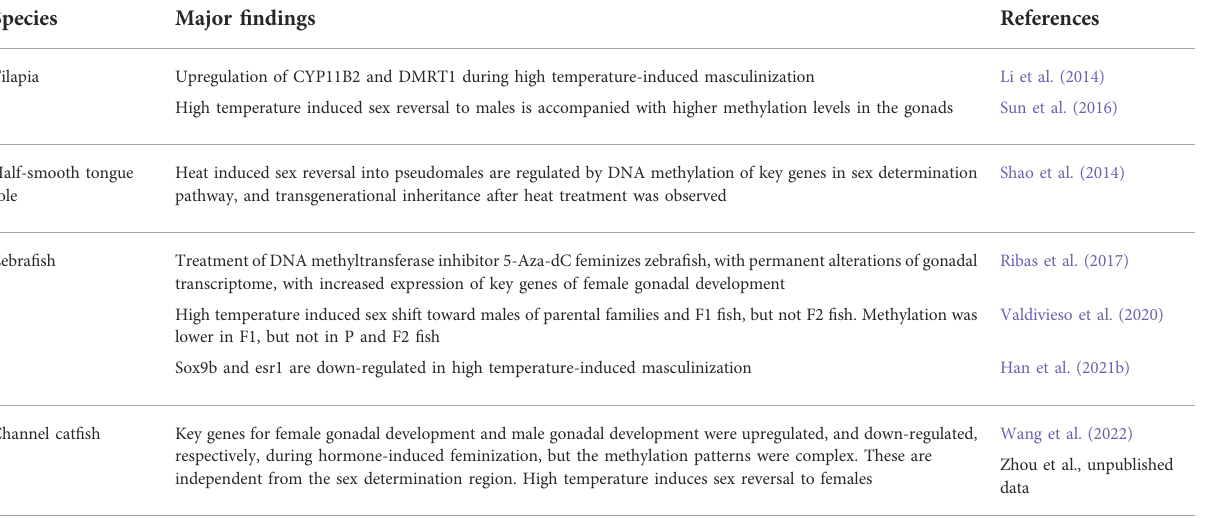
TABLE 6 Methylation/demethylation of speci fi c genes and their involvement in sex reversal/sex ratio shift. Species